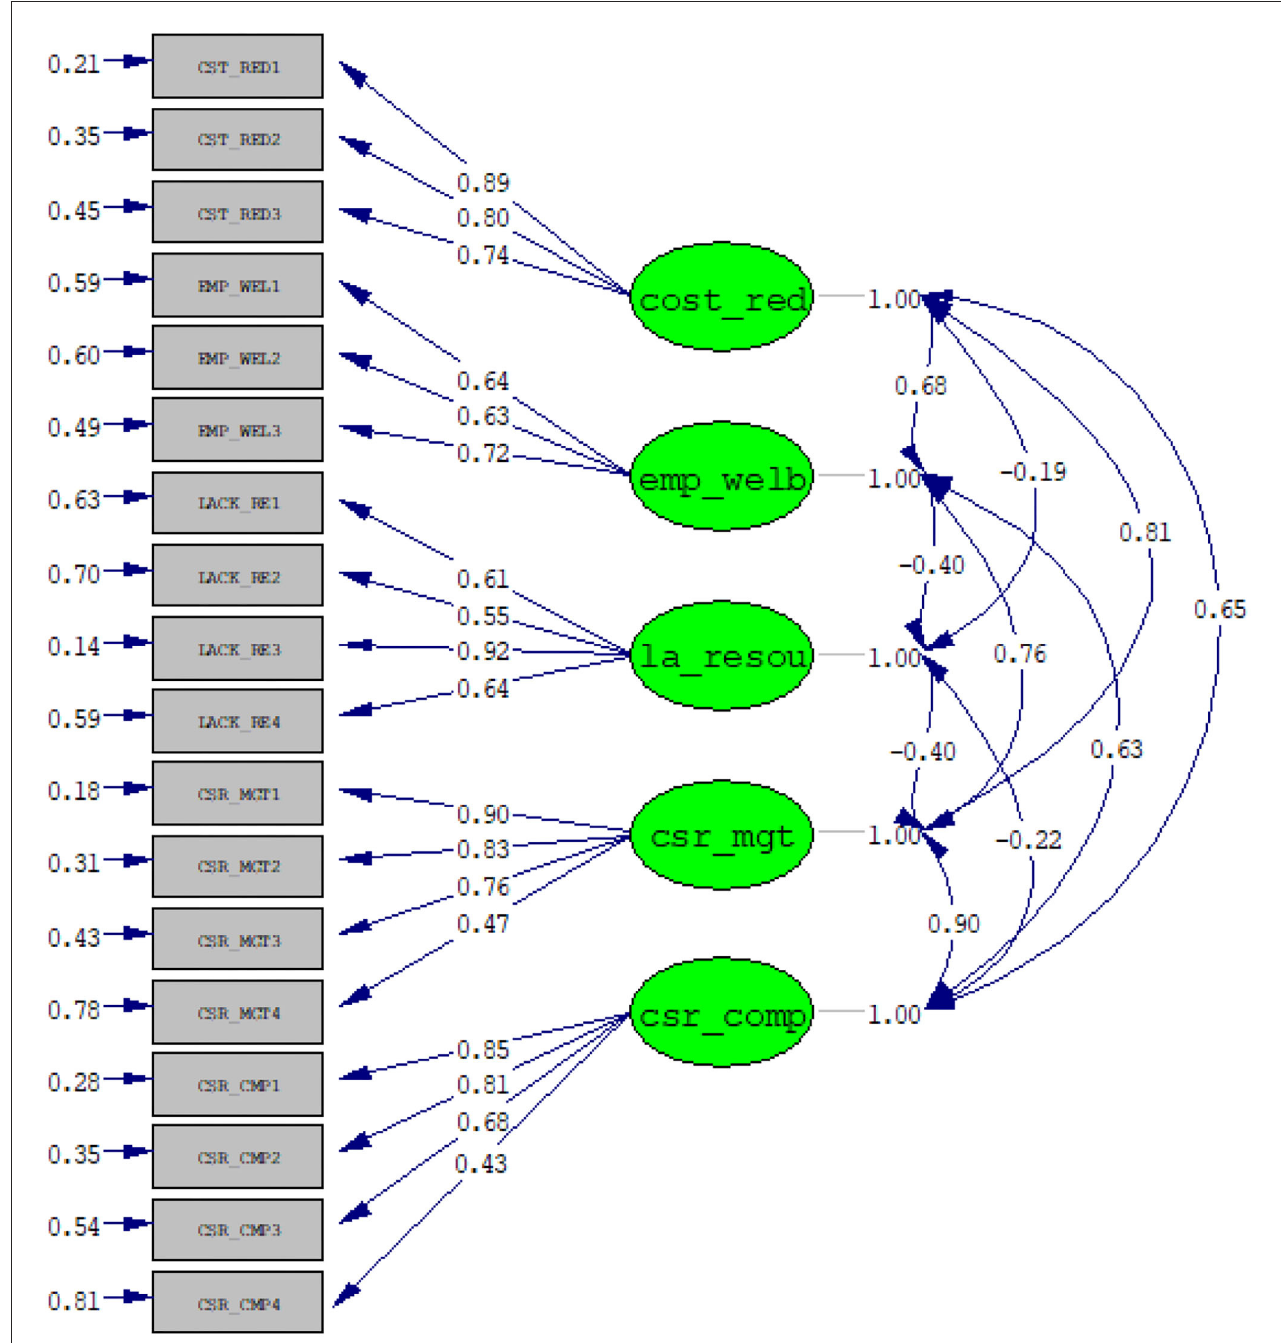
FIGURE2 Confirmatory factor